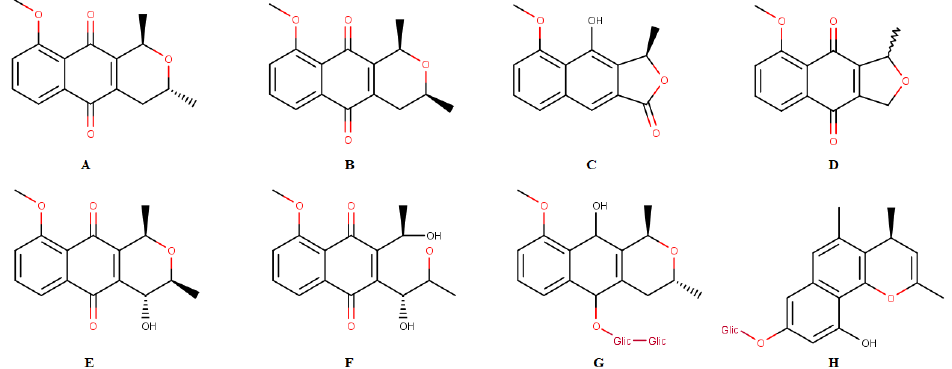
Figure 1. Chemical constituents isolated from Eleutherine plicata : isoeleutherin ( A ), eleutherin ( B ), eleutherol ( C ), eleutherinone ( D ), (R) 4-Hydroxyeleutherine ( E ), eleuthrone ( F ), isoeleuthoside C ( G ), eleutherinol-8-O- β -D-glucoside ( H ). Samples of E. plicata were submitted to the micronucleus assay and we observed that the fractionation of the ethanol extract from E. plicata bulbs (EEEp) led to a fraction with higher toxic potential (Dichloromethane Fraction (FDCMEp)). Eleutherin and isoeleuthe-